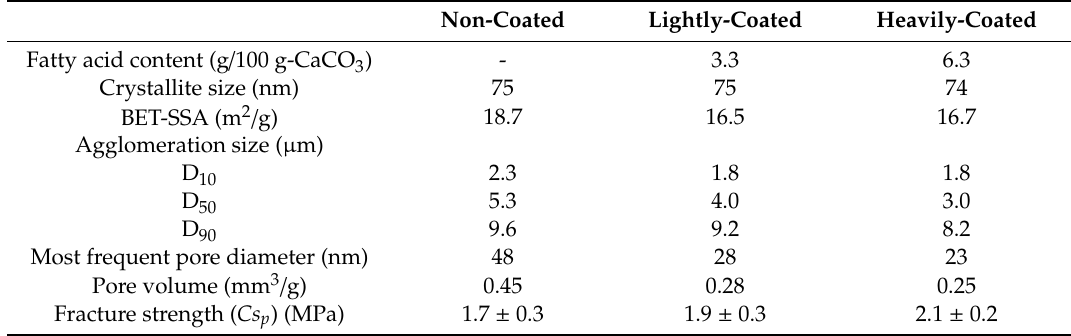
Table 1. Powder characteristics of the non-coated, lightly-coated, and heavily-coated calcium carbonate